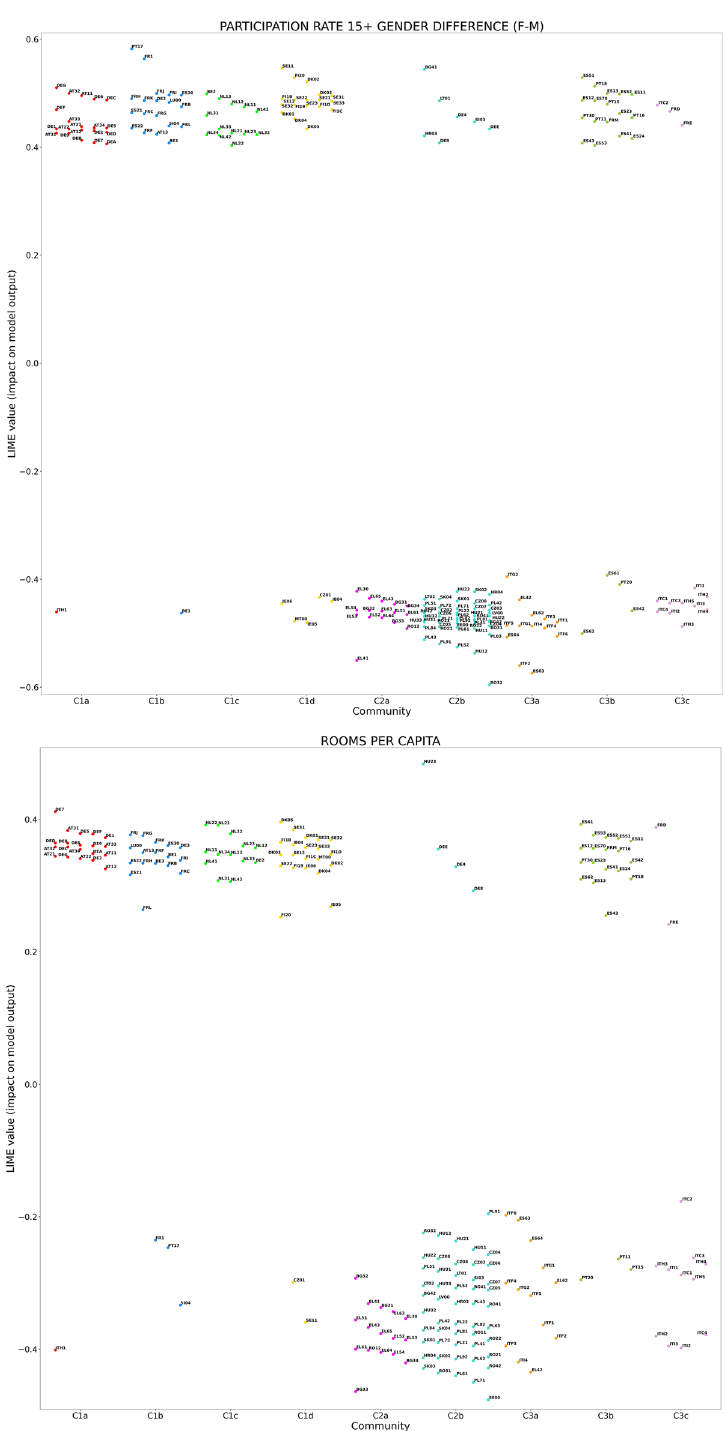
Figure 8. Distributions in the subregion network communities (reported on the horizontal axes) of the LIME values related to the two indicators that show the highest impact, in terms of mean absolute LIME value, on the prediction of EQI scores. In both cases, the distributions are characterized by R > 1 with respect to the network partition, highlighting the tendency of indicators to have similar LIME values in regions belonging to the same community and relevant differences across